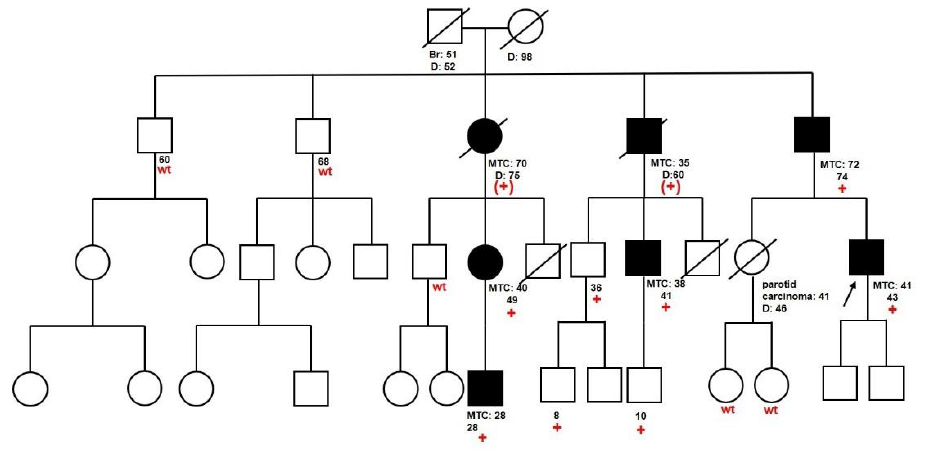
Figure 1. Family tree of family 91-O-03. We report the age at diagnosis of MTC and the age at death or at the last follow-up of patients evaluated at our clinic and / or who developed MTC; in red, we indicate the result of RET analysis (“ + ” = carrier of p.Ser904Phe variant; “( + )” = obligate carrier of the variant; “wt” = testing negative).